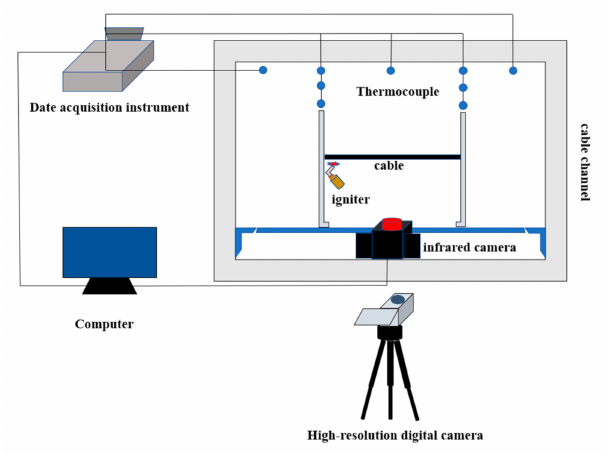
Figure 1. Schematic diagram of experimental